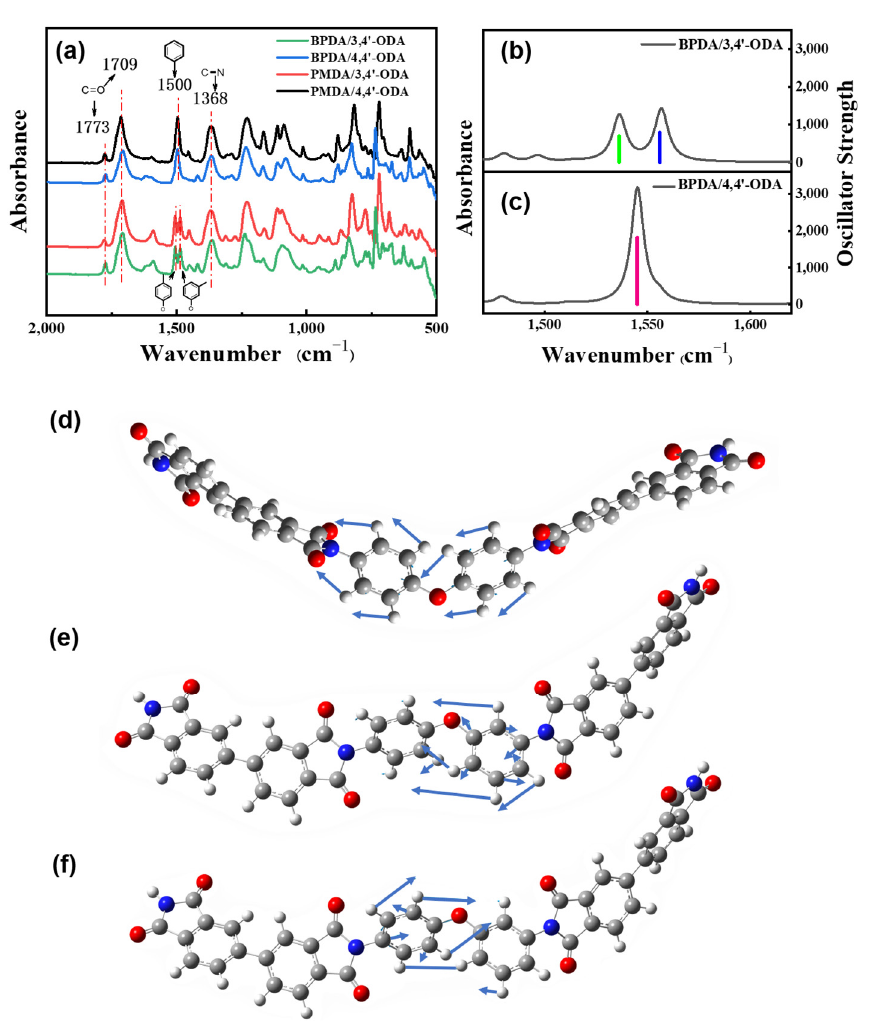
Figure 3. ( a ) The FT-IR curves of PI films; ( b ) the FT-IR simulation curve of BPDA/3,4 ′ -ODA; ( c ) the FT-IR simulation curve of BPDA/4,4 ′ -ODA; ( d – f ) the vibration trajectory of the functional group.